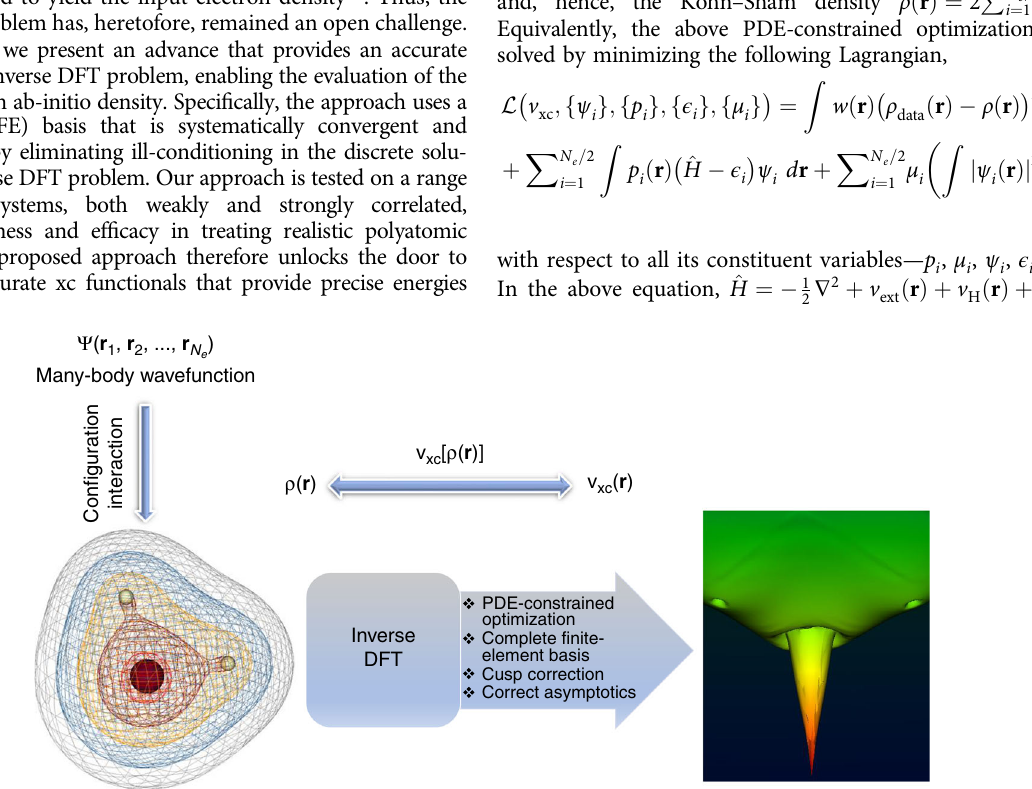
Þ ) and, hence, the ground-state electron e ) xc ð r Þ